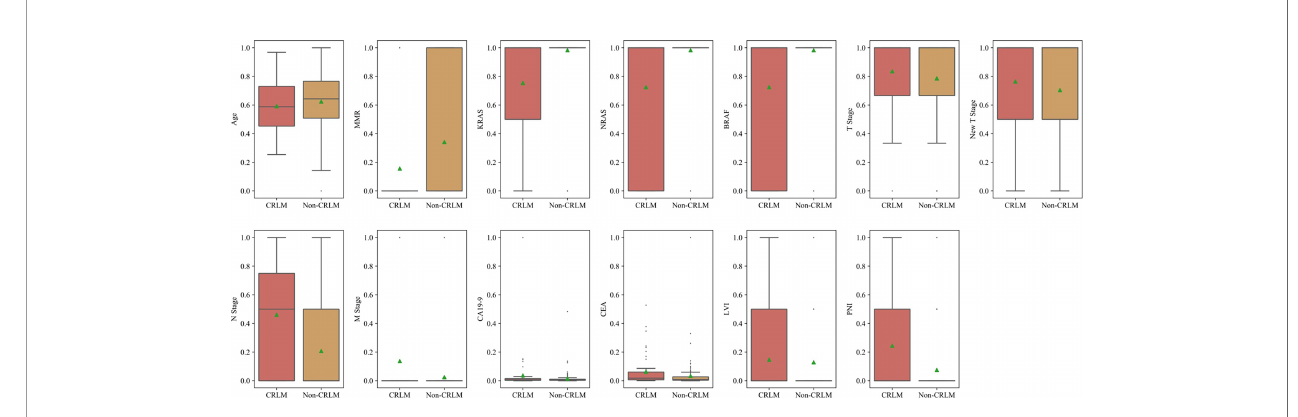
FIGURE 2 | Box plot of clinical features of CRLM and